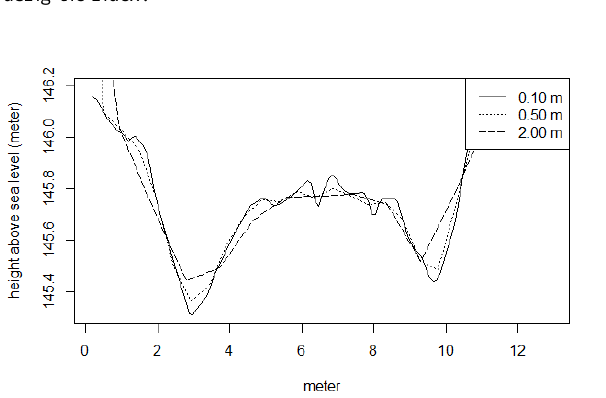
Figure 1. Road cross-section of DEMs interpolated from high- pulse density ALS dataset. All resolutions represent the same cross section.